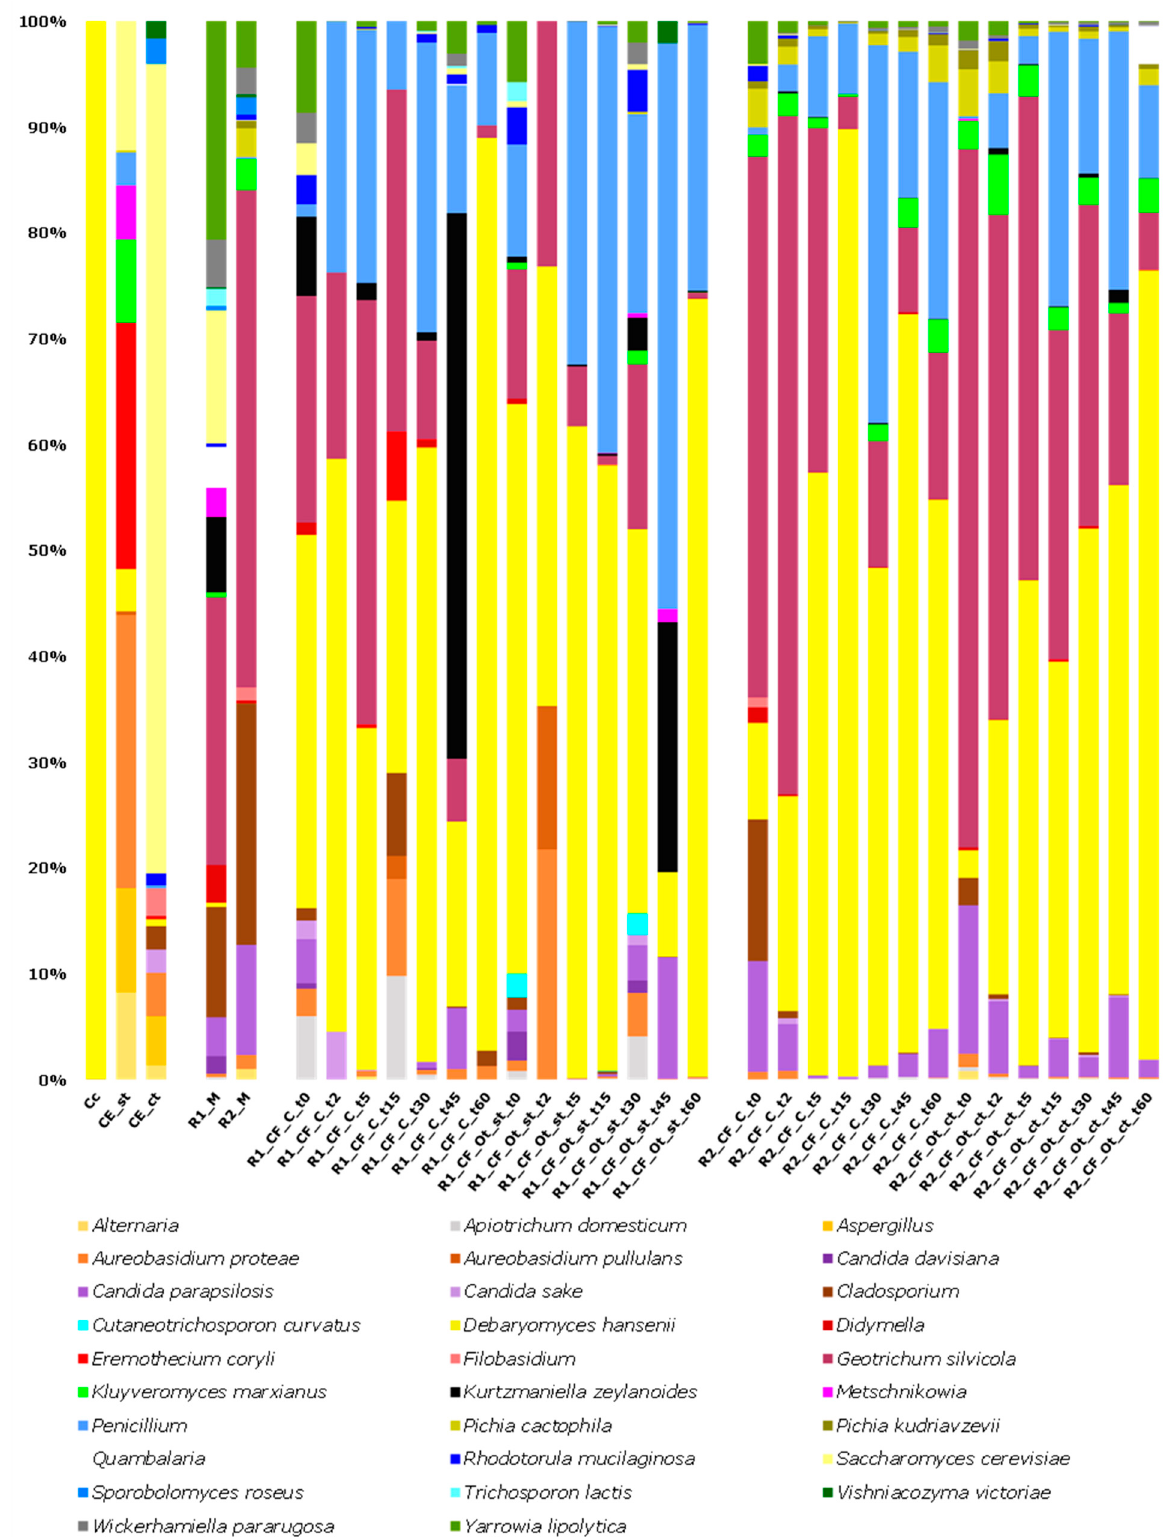
Figure 7. Relative frequency of the fungal ASVs detected by Illumina DNA sequencing in thistle- based coagulants (Cc, CE_st, CE_ct), milk (R1_M, R2_M), control (CF_C), and experimental (CF_Ot_st and CF_Ot_ct) cheeses sampled during ripening. Only ASVs with an incidence above 1% in at least two samples are shown.